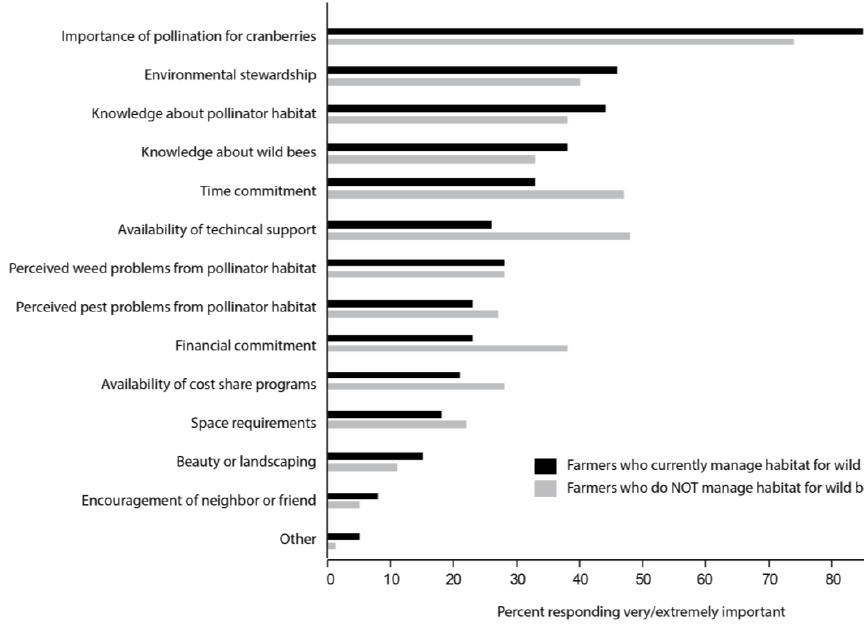
Figure 1. Percent of growers responding “very” or “extremely” to how important each factor is in their decision whether or not to manage for wild bees (Q26).